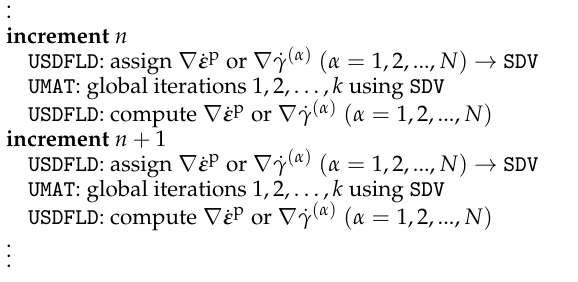
Algorithm 1. Equilibrium solution scheme including gradient computation and user defined material in the commercial FE software package A BAQUS . . . .